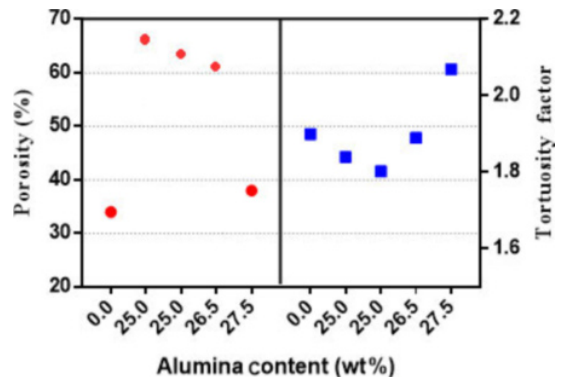
Fig. 8 Porosity and tortuosity of the kaolin and kaolin/alumina hollow fibre membrane as a function of alumina content.